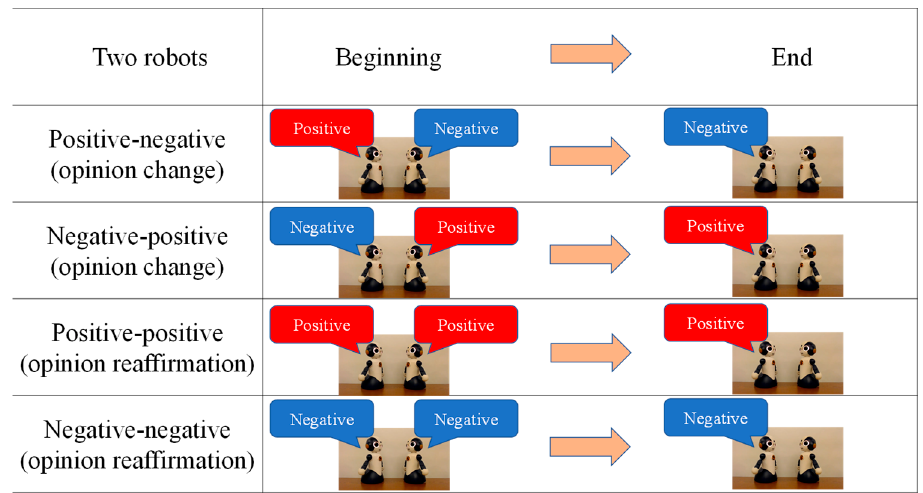
Figure 1. Opinion changes and reaffirmation of visual stimuli.